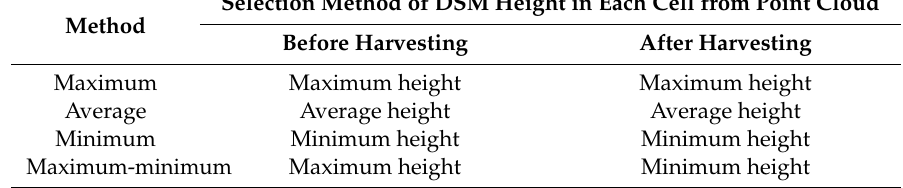
Table 1. Acquisition method of height data in each cell of digital surface model (DSM) from point